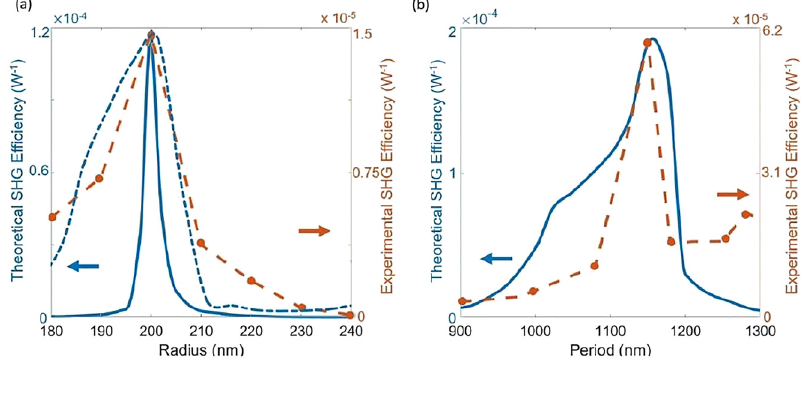
Figure 5: (a) Microscope image of SHG from in-plane isolated nano-resonator in the multilayer structure with radius equal to 185 nm. (b) Measured (orange curve) and calculated (blue curve) SHG ef fi ciency from (a) as a function of